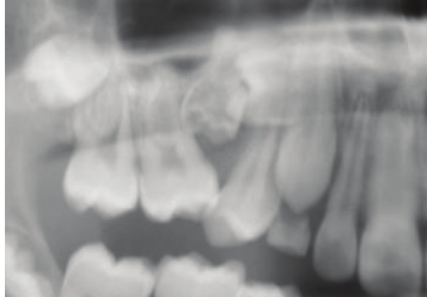
Figure 10: Section of a panoramic radiograph from a 14-year-old boy. The radiograph shows retention of the right primary second maxillary molar. The tooth has ankylosed and is not shed sponta- neously. The tooth blocks normal development of the permanent dentition in the right side.